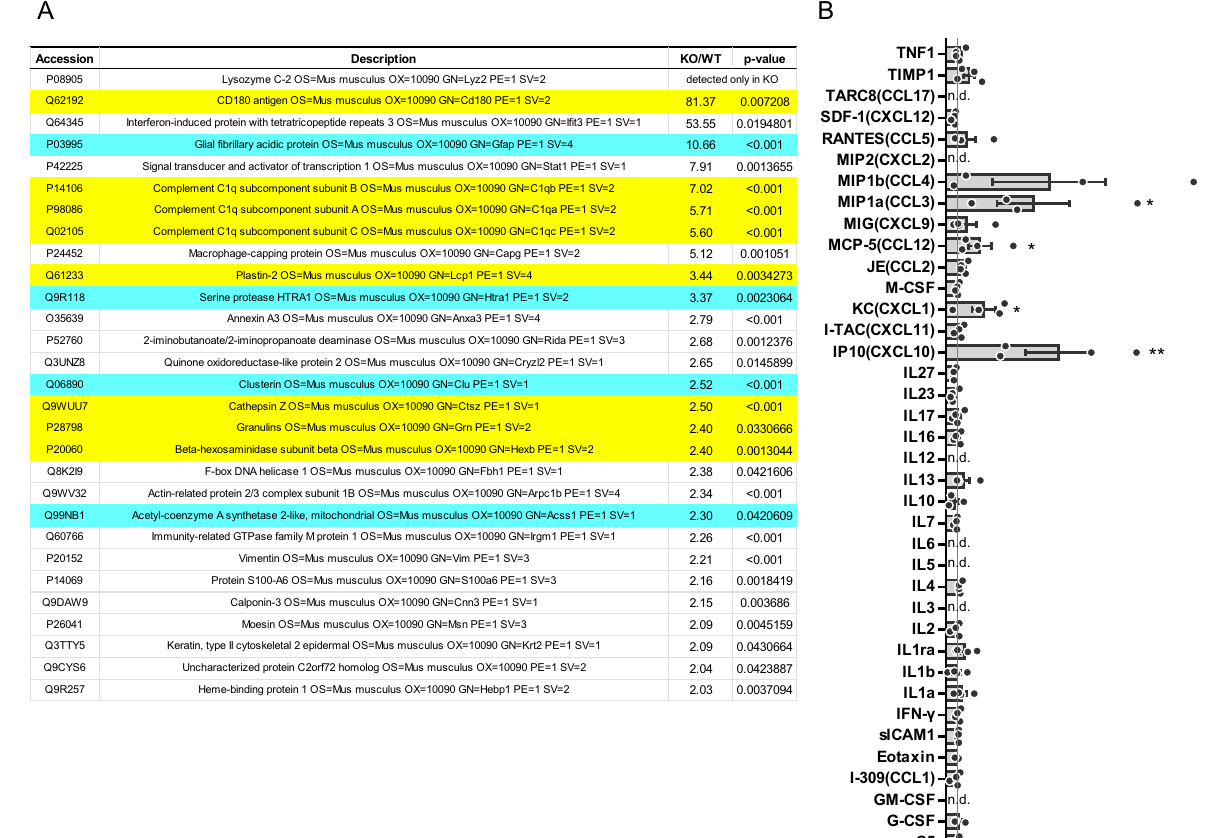
Figure 3. Comprehensive analyses of GCLC-KO mouse brains. ( A ) Proteomic analyses were performed using protein samples from the cortices of 4-month-old WT and GCLC-KO. Values shown in the table represent the relative expression level of each protein in GCLC-KO/WT. Proteins whose expression levels were > twofold greater in GCLC-KO, in addition to being significant at the p < 0.05 level, are listed. Yellow and cyan highlights proteins whose mRNA are abundant in microglia or astrocytes, respectively. The mRNA expression of each protein was referred to Mousebrain.org (http:// mouse brain. org/ genes earch. html). ( B ) Protein levels of cytokines in 4-month-old WT and GCLC-KO were determined by cytokine array. Values shown in the graph represent the mean relative expression level of cytokines in GCLC-KO/WT (n = 4; * p <